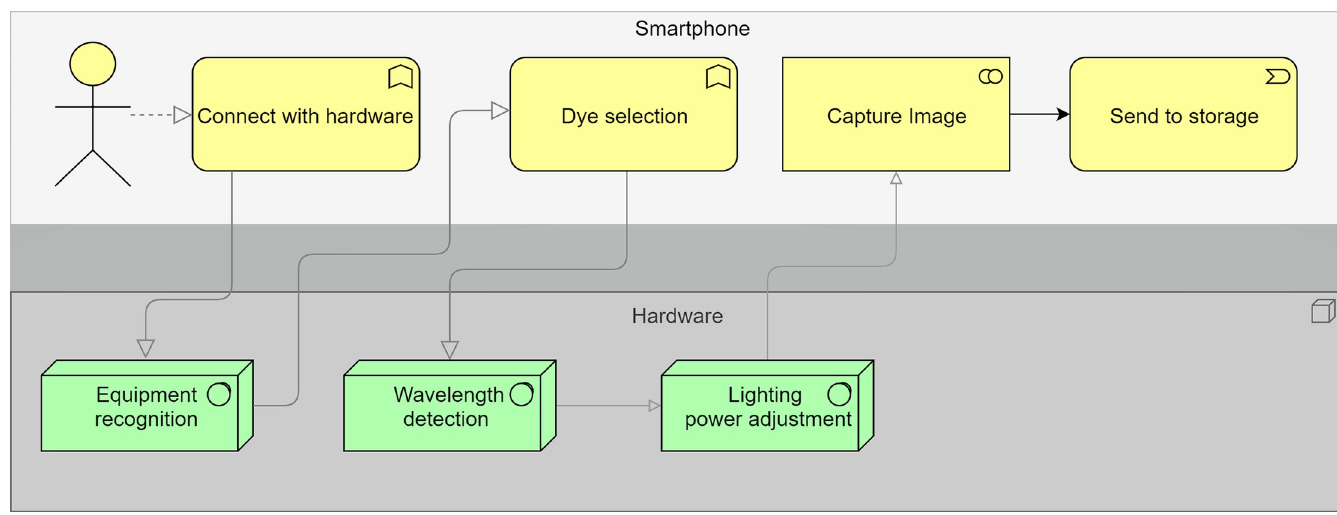
Fig 1. A schematic diagram demonstrating an overview of the model’s project. The diagram also describes the tasks executed by the smartphone software (yellow boxes) and by the hardware (green boxes), and their respective workflow.